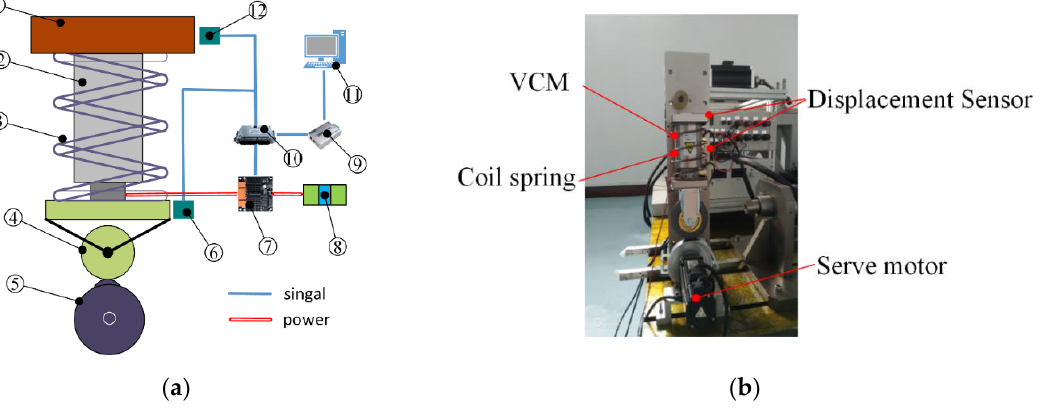
Figure 4. Experimental Section apparatus: ( a ) schematic diagram; ( b ) Physical diagram. ① body; ② voice coil motor; ③ spring; ④ wheel; ⑤ servo motor and cam; ⑥ linear displacement sensor 1; 2 (cid:13) voice coil motor; 3 (cid:13) spring; 4 (cid:13) wheel; 5 (cid:13) servo motor and cam; 6 (cid:13) linear displacement sensor 1; ⑦ motor drive H-bridge; ⑧ battery; ⑨ USB-CAN module; ⑩ controller; ⑪ computer; ⑫ linear 7 (cid:13) motor drive H-bridge; 8 (cid:13) battery; 9 (cid:13) USB-CAN module; 10 (cid:13) controller; 11 (cid:13) computer; 12 (cid:13) linear displacement sensor 2. displacement sensor 2.